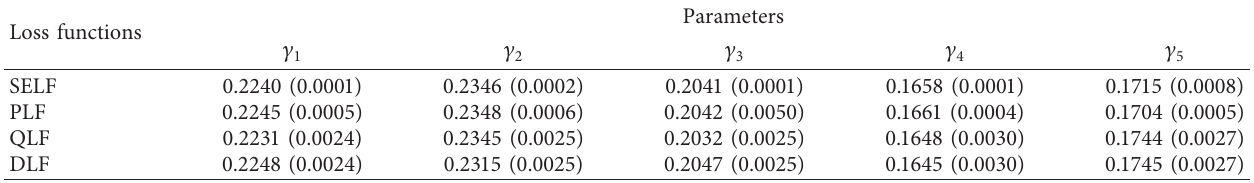
Table 2: Bayes estimates (BEs) and posterior risks (PRs) using uniform prior.